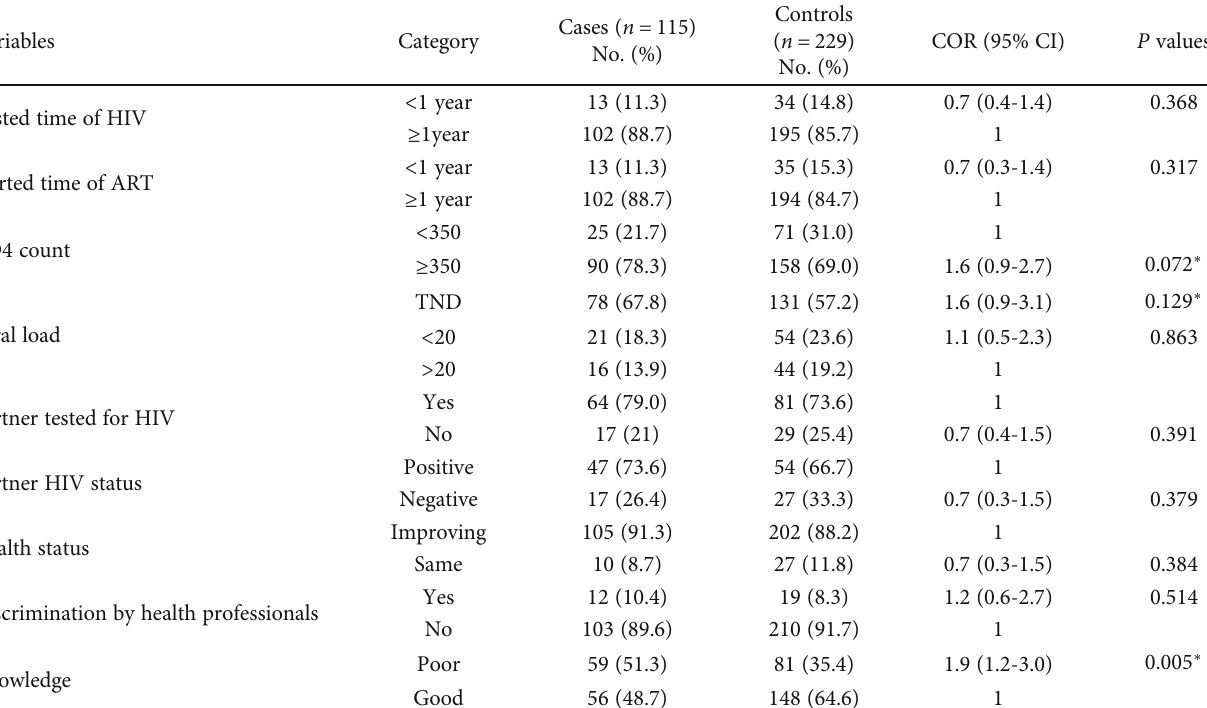
Table 4: Bivariate analysis of clinical characteristics of women living with HIV attending ART in Jimma University Medical Center, 2019 ( N = 344